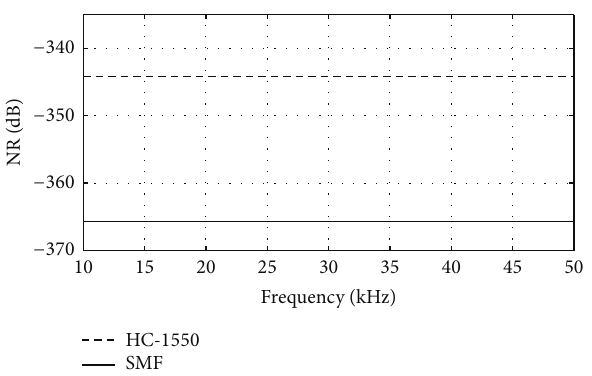
Figure 4: NR of the HC-1550 and SMF as a function of acoustic frequency.